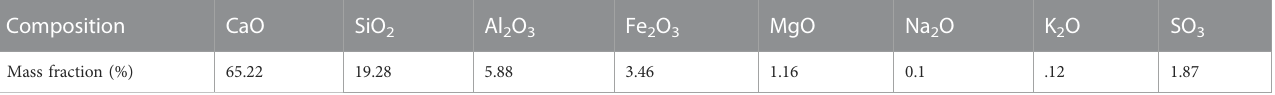
TABLE 1 Chemical composition of the used ordinary Portland cement (OPC).